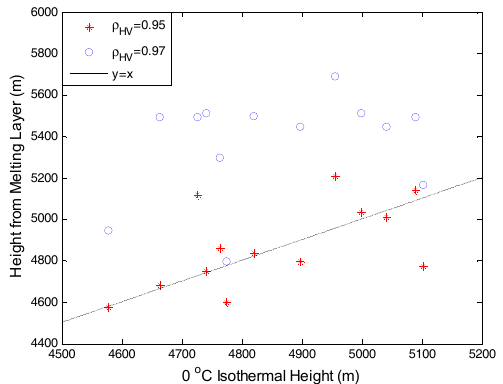
Figure 8. Scatter plot between 0 °C isothermal height and convective rain melting layer top height detected using two different thresholds .